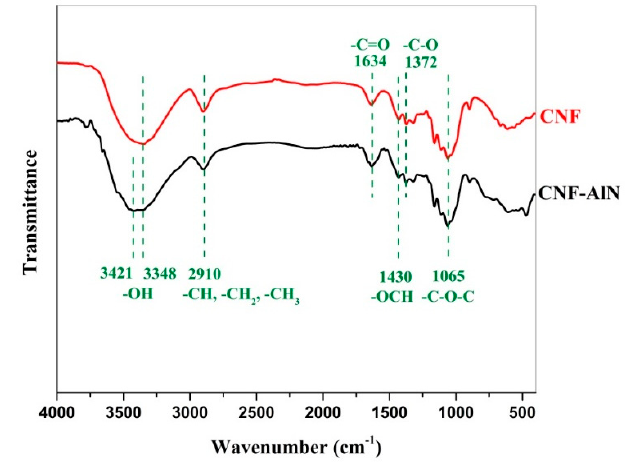
Figure 6. FTIR spectra of CNF and CNF-AlN composites.